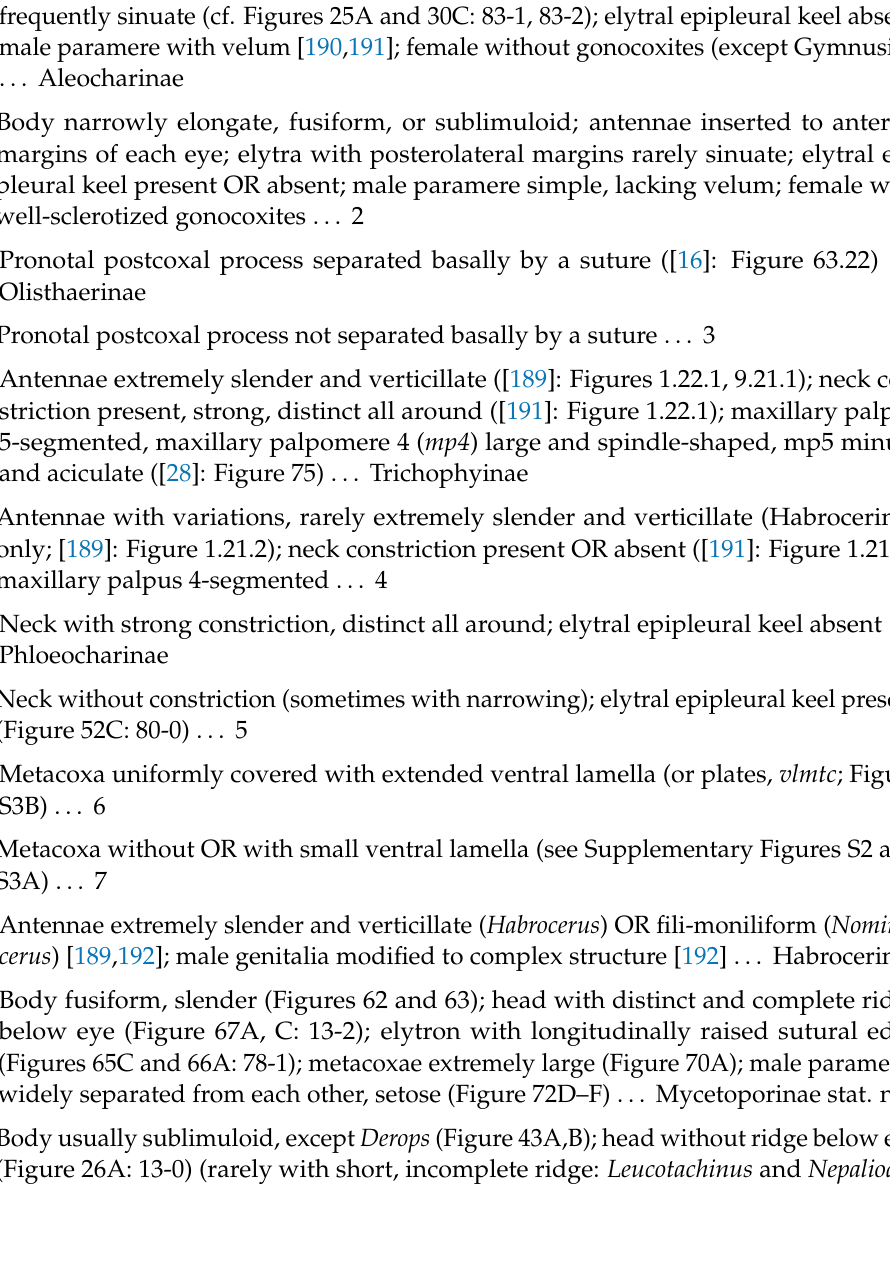
(Figure 26A: 13-0) (rarely with short, incomplete ridge: Leucotachinus and Nepaliodes